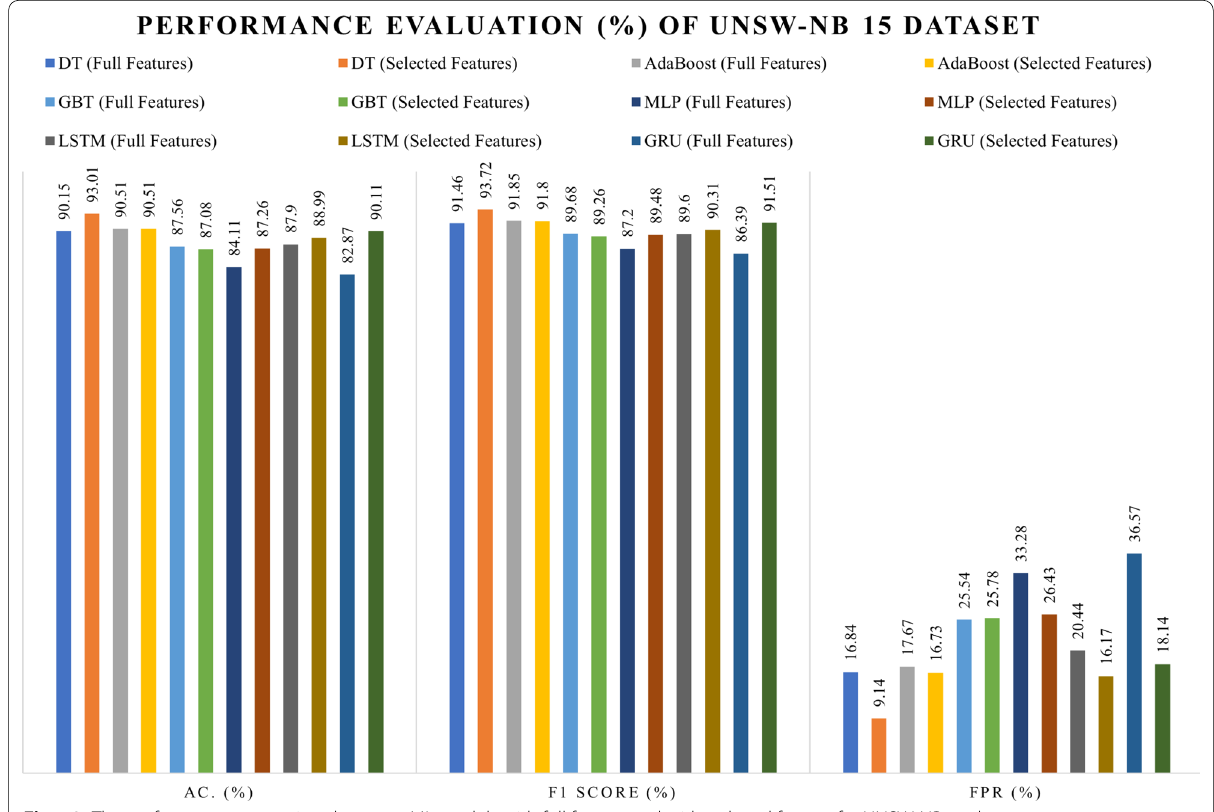
Fig. 10 The performance comparison between ML models with full feature and with reduced feature for UNSW-NB 15